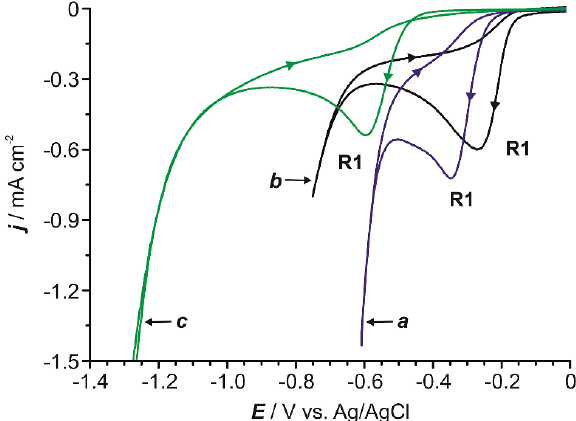
Figure 2. Cyclic voltammograms for a 0.6 mM aqueous solution of 4-NP (0.1 M Na 2 SO 4 ) at pH = 2.0 using gold ( a ), silver ( b ) and GC ( c ) working electrodes under quiescent conditions. In all instances, the scan rate was 50 mV s −1 .